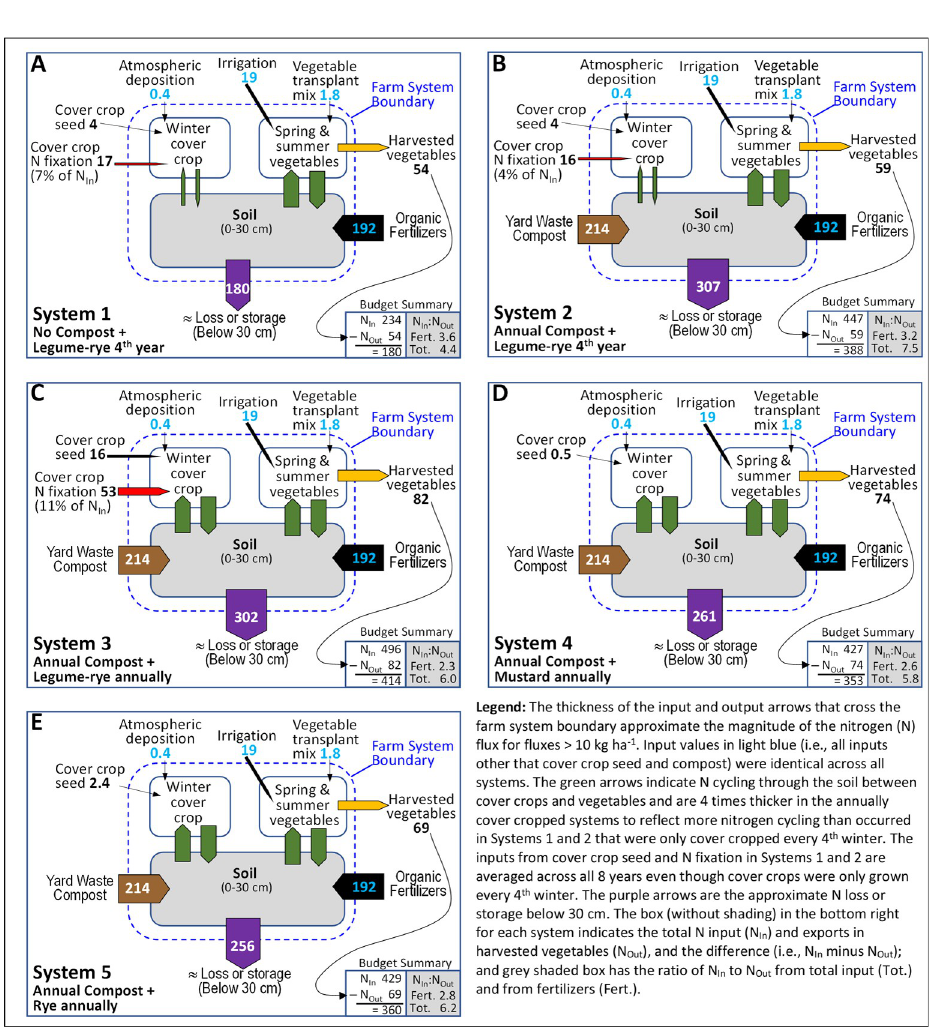
Fig 11. Average annual nitrogen inputs, exports and storage or losses in five organic vegetable systems over 8 years. Values are in kg ha -1 and were calculated from the cumulative values in Table 2. Systems differed by annual compost additions, cover crop type and cover cropping